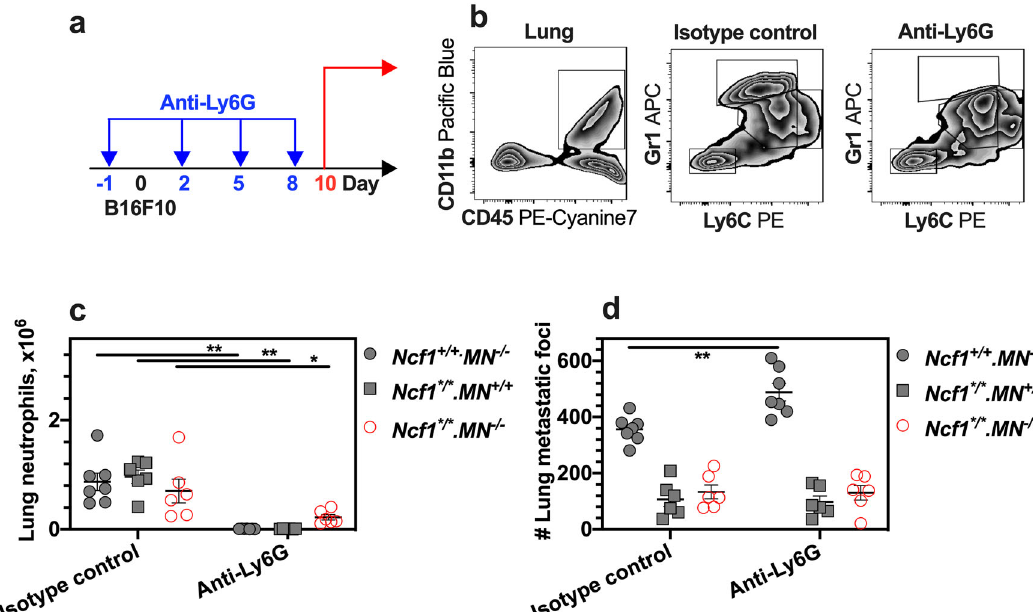
Fig. 4 Treatment with anti-Ly6G antibodies increases lung colonization for mice with NCF1-expressing neutrophils. The studies used wild-type mice ( Ncf1 + / + . MN − / − ), MN mice ( Ncf1 */* . MN + / + ), and Ncf1 mutant mice ( Ncf1 */* . MN – / − ). B16F10 cells that were injected into mice at day 0, and the number of tumor colonies in lungs per mouse was counted at day 10 post-injection of B16F10 cells. a Administrations of anti-Ly6G antibodies were applied at days − 1, 2, 5, and 8 post-injection of B16F10 cells. The study includes the wild-type mice with injections of anti-Ly6G antibody (clone:1A8; n = 7) versus isotype control (clone:2A3; n = 7), MN mice with injections of 1A8 ( n = 6) versus 2A3 ( n = 6), and Ncf1 mutant mice with injections of 1A8 ( n = 6) versus 2A3 ( n